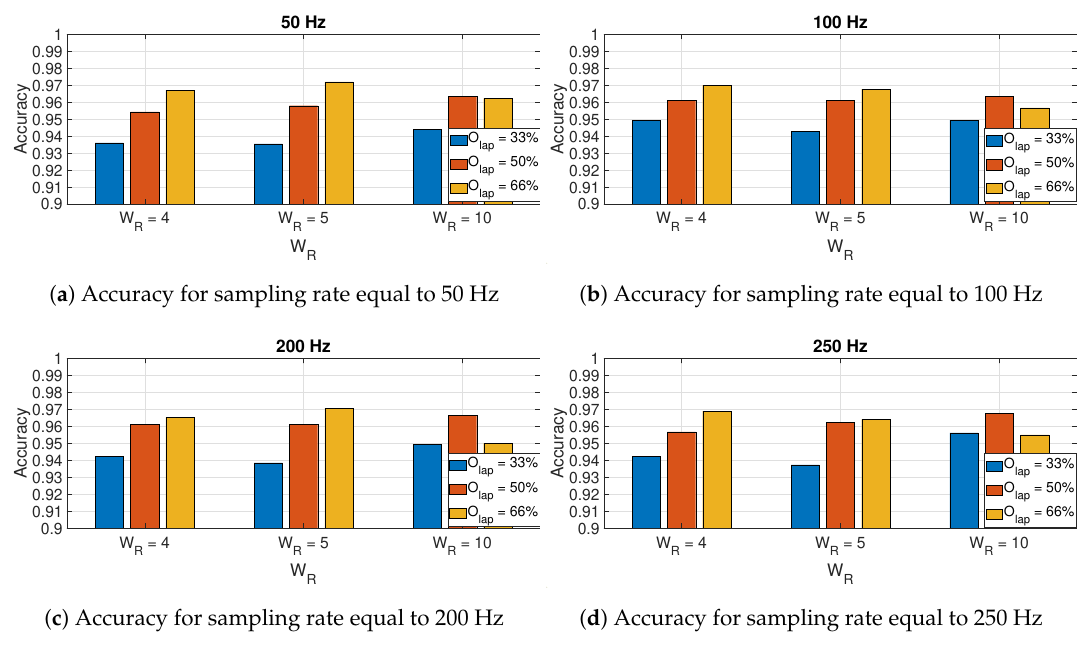
Figure 12. Accuracy for GyroY in relation to the size of window (based on the W R factor) used in the spectrogram for different sampling rates and different values of the overlapping factor O lap . The Hamming window is used to obtain these results.